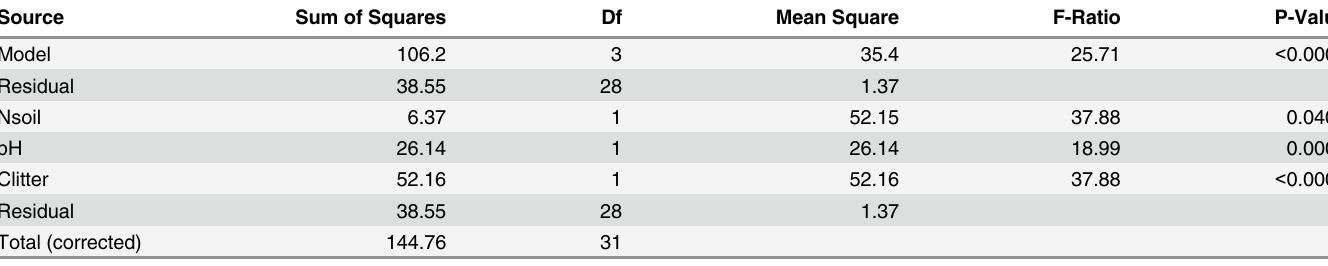
Table 6. Best general linear model for the relationship of PC1 with ecosystem properties.